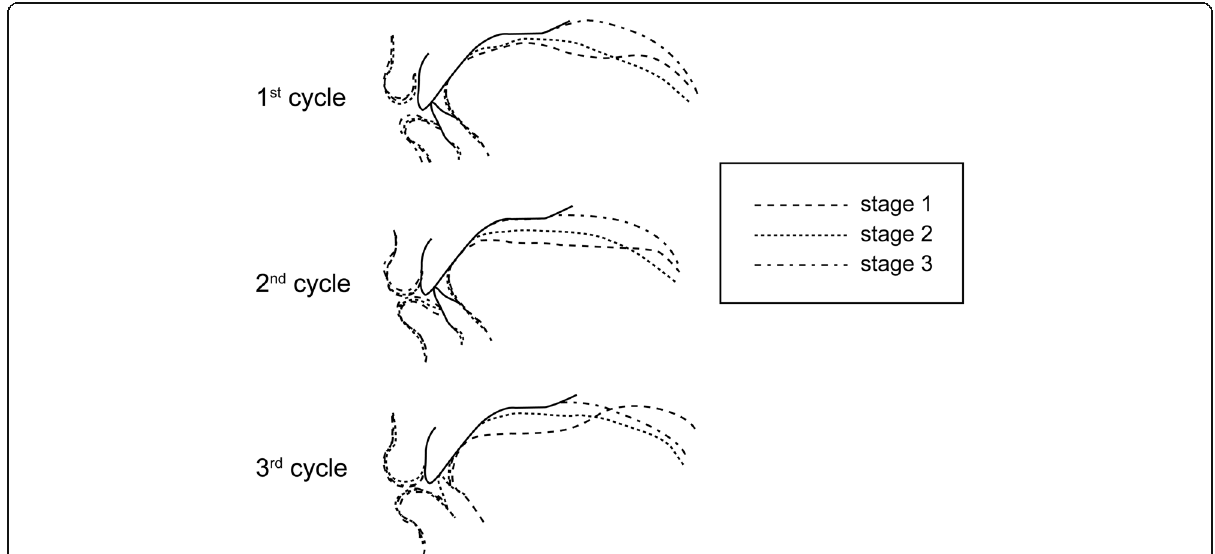
Fig. 7 Comparison of images from a representative subject at each stage of deglutition. Tracings were made at stages 1, 2, and 3 of deglutition for each cycle